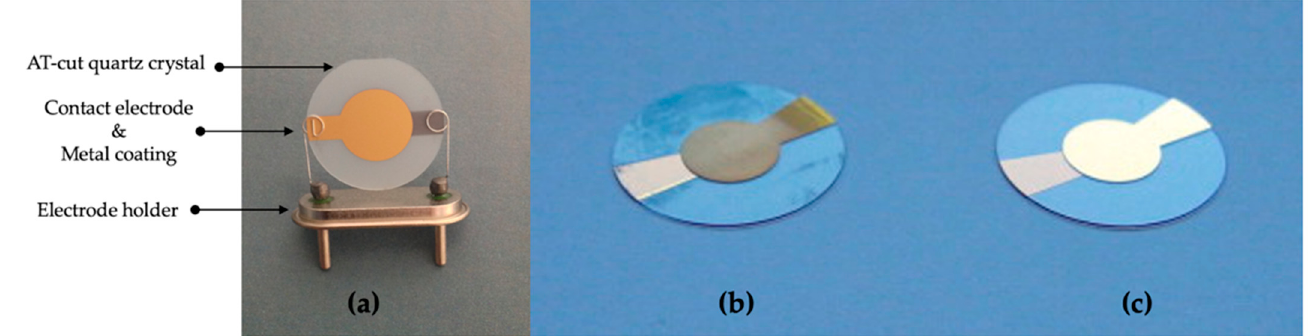
Figure 3. A quartz crystal with gold electrodes: ( a ) typical AT-cut piezoelectric crystal coated with two gold electrodes, one on each side; reprinted with permission from Ref. [75] 2015, Bragazzi. Modified gold electrode ( b ) and bare gold surface ( c ) of AT-cut quartz with keyhole electrode. Reprinted with permission from Ref. [105] 2010, Biemmi.